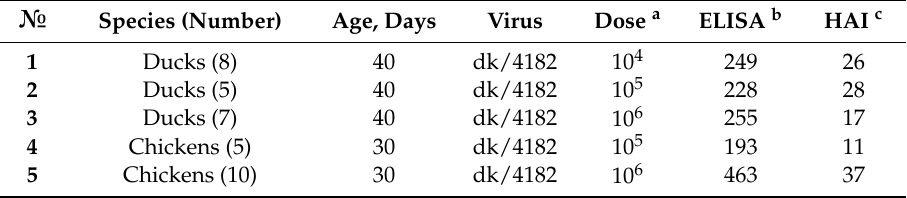
Table 2. Levels of antibodies following primary oral administration of dk/4182 to ducks and chickens. Species